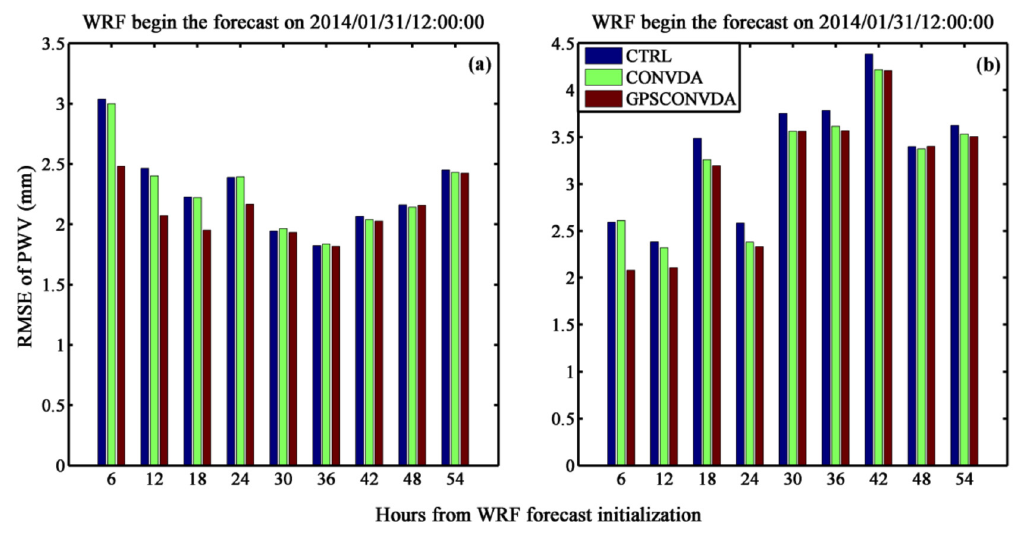
Figure 3. Six hourly RMSEs in predicted PWV using different experiments: CTRL, CONVDA and GPSCONVDA from the WRF forecast initialization in both case studies (a) February 1, 2014 and (b) September 17,